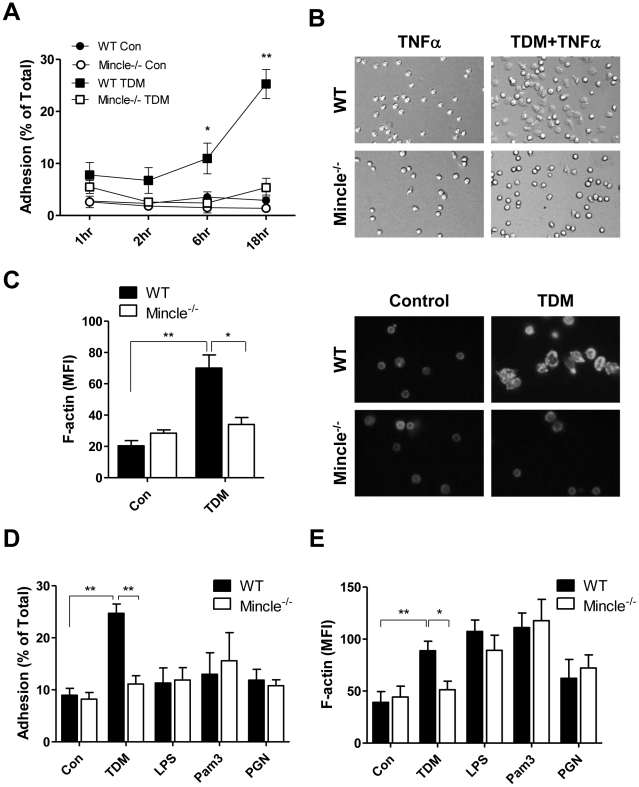
TDM-induced neutrophil adhesion and F-actin polymerization are Mincle dependent.(A) Firmly-adherent wild-type (WT) and Mincle−/− bone marrow (BM) neutrophils were counted after incubation in the presence or absence of 25 µg/ml trehalose dimycolate (TDM). Statistical significance is shown relative to unstimulated control (con) for each group. *p<0.05 and **p<0.01. (B) Firmly-adherent WT and Mincle−/− BM neutrophils treated with TNFα and/or TDM for 60 min were imaged by phage-contrast microscopy. Original magnification was 400×. (C) BM neutrophils were cultured on TDM-coated coverslips for 60 min, and F-actin polymerization was monitored by immunofluorescent microscopy (right). Images are representative of three independent experiments. Alexa 568-phalloidin staining was quantified by mean fluorescence intensity (MFI, left). Statistical significance: *p<0.05 and **p<0.01. (D–E) Neutrophil adherence (D) and F-actin polymerization (E) stimulated by TDM, LPS, Pam3CSK4, or peptidoglycan for 18 h (D) or 1 h (E). Statistical significance: *p<0.05 and **p<0.01. Data are expressed as means ± SEM from at least three independent experiments.